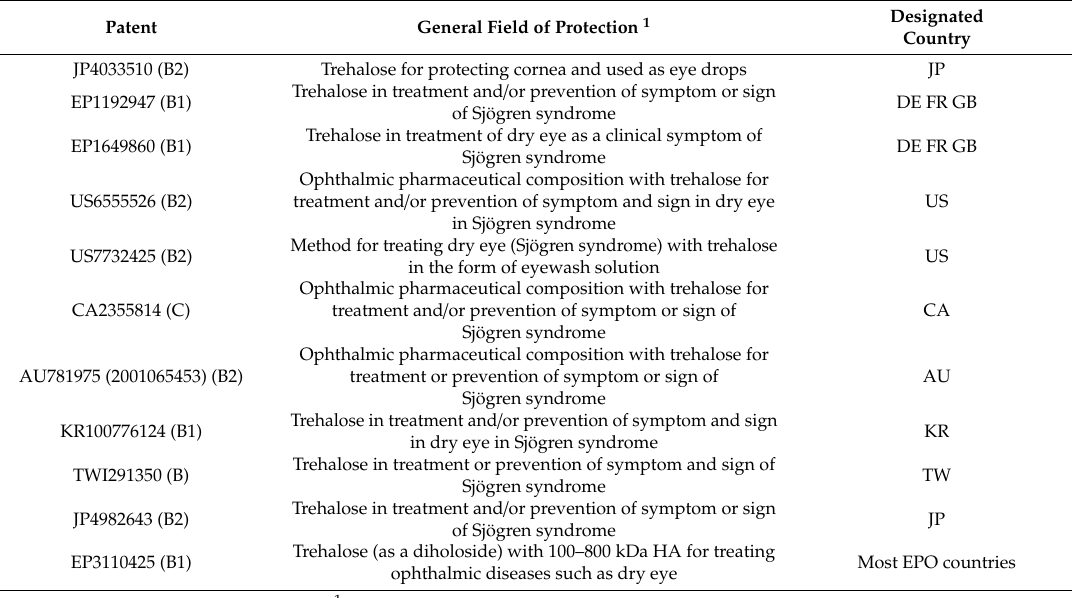
Table 2. Summary of granted patents on trehalose for dry